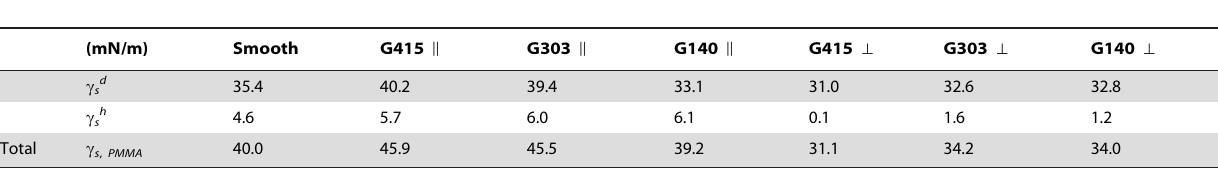
Table 2. Calculated surface free energy values for PMMA